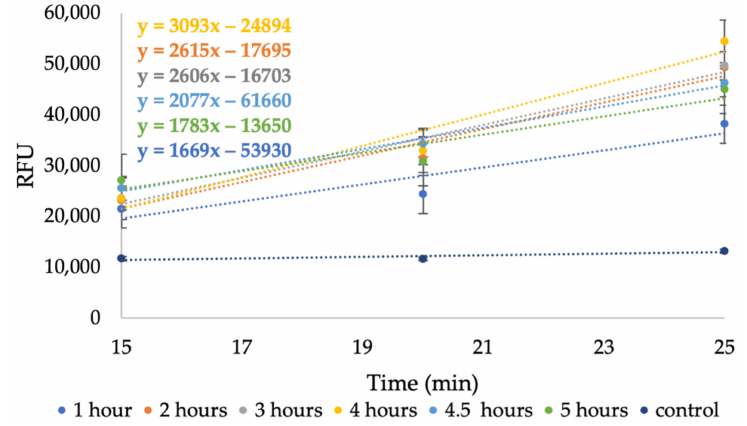
Figure 7. The RFU signal increase rate for 1–5 h hydrolysis between 15–25 min of testing. SEM imaging of the obtained NC is presented in Figure 8. Rod-shaped particles were observed with an average diameter and length of 165 nm and 2431 nm, respectively, suggesting cellulose nanofibrils. Understanding NC’s morphology is essential for its efficient application; Bharimalla et al. (2015) reported that NC with a high diameter to length ratio is suitable for filters and sorbents [74], similar to the application proposed in the current study.